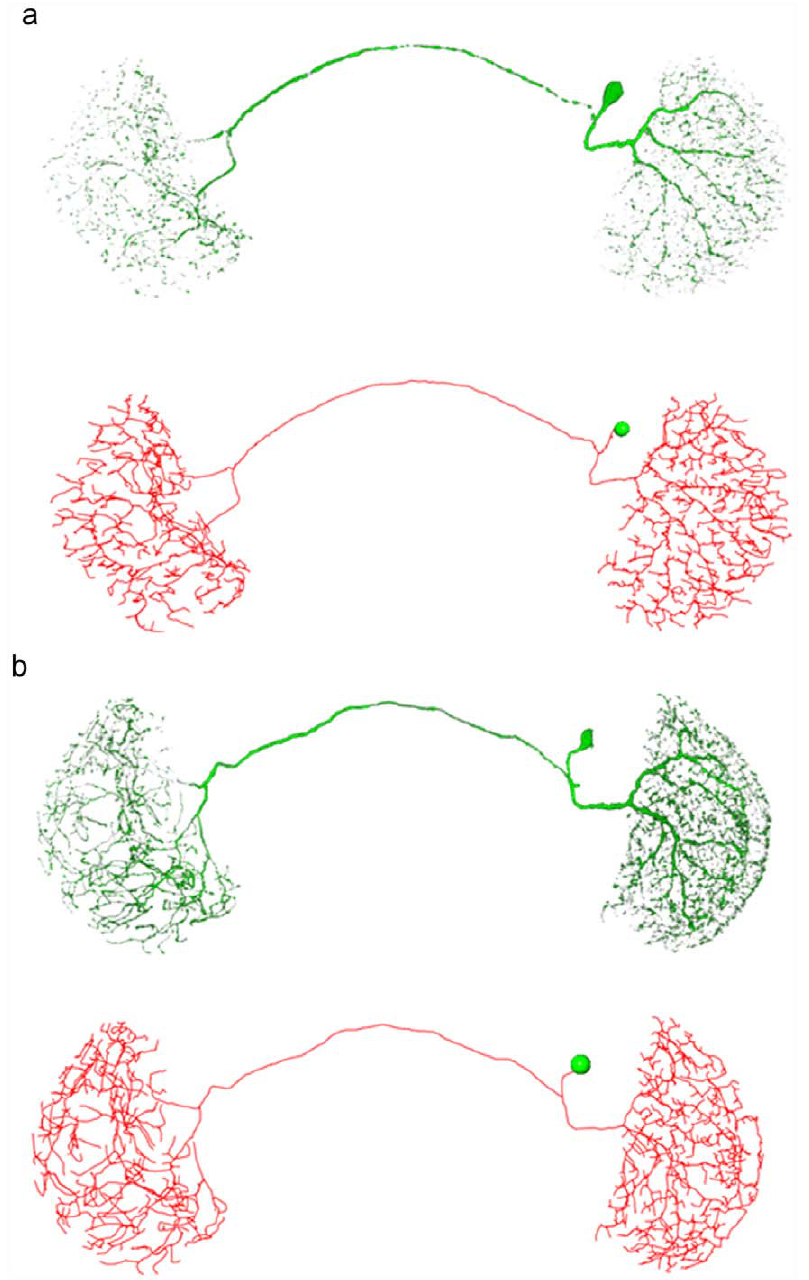
Figure 2. Two reconstruction results of optical nerves were demonstrated. Both (a) and (b) show the neurons (top) and the traced results (bottom). The projection neuron connecting optical lobes has dense branches and complex morphology. In addition, the intensity of the neuron in (a) has a wide dynamic range. The proposed method can manage these situations and make necessary corrections. When the whole process is completed, the reconstructions of both neurons are complete with high fidelity.